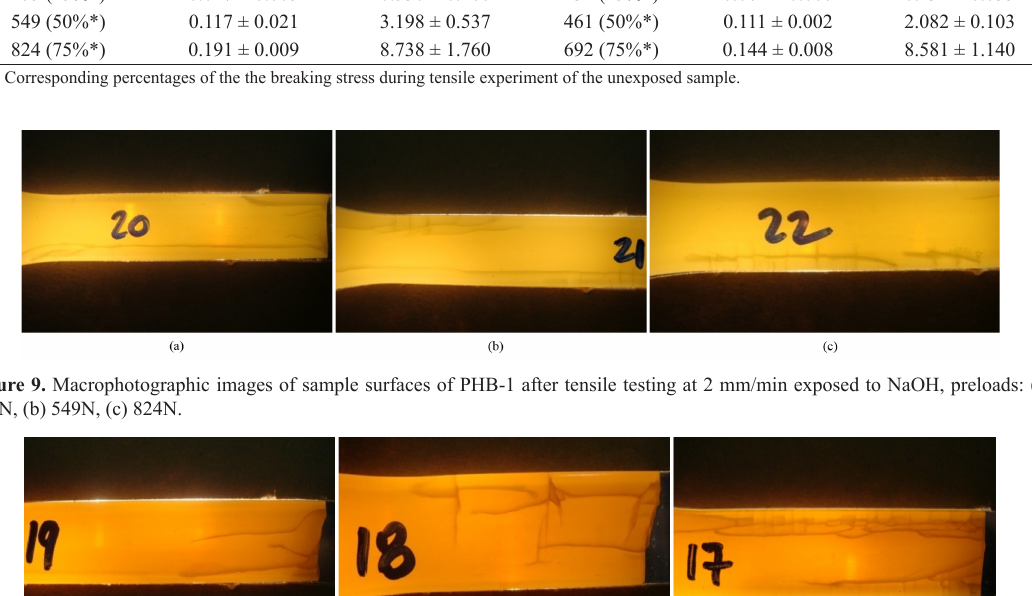
Table 3. Relaxation rate under several preloads of PHB-1 and PHB-2 samples unexposed and exposed to NaOH. Preload (N)